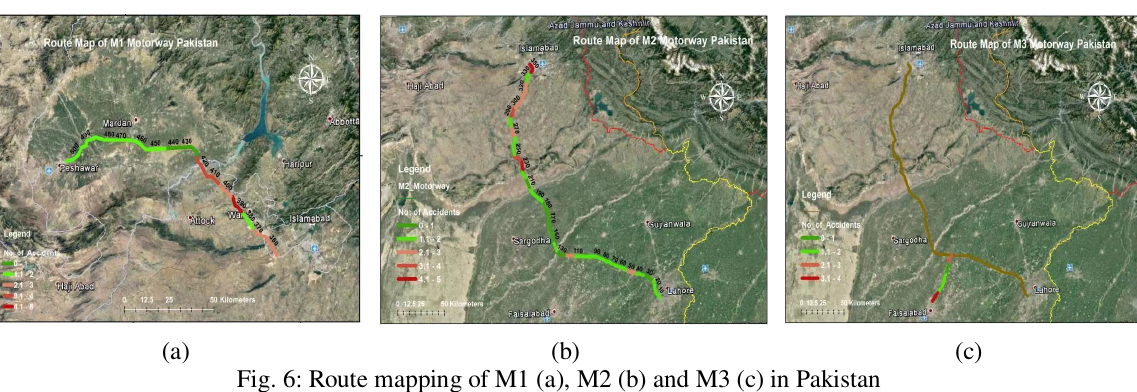
Fig. 6: Route mapping of M1 (a), M2 (b) and M3 (c) in